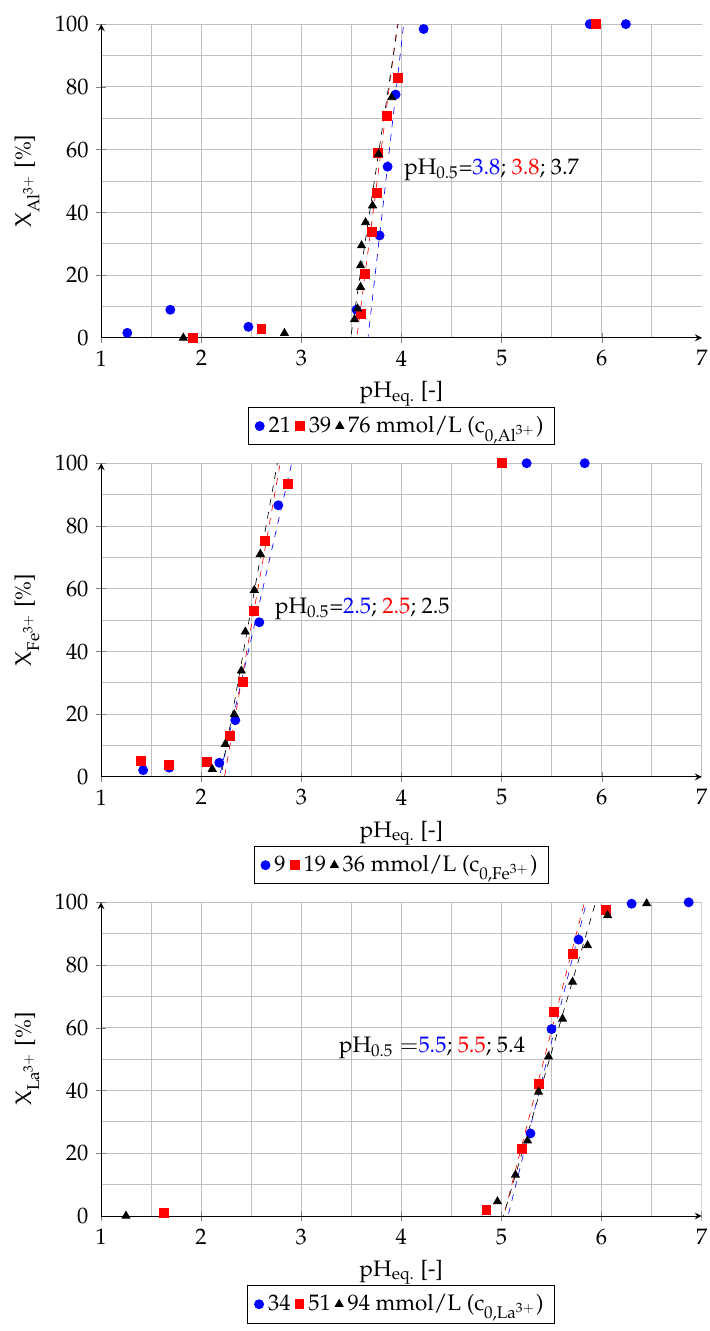
Figure 3. Effect of equilibrium pH value of raffinate on extraction yield from single-component solutions (experiment (2)